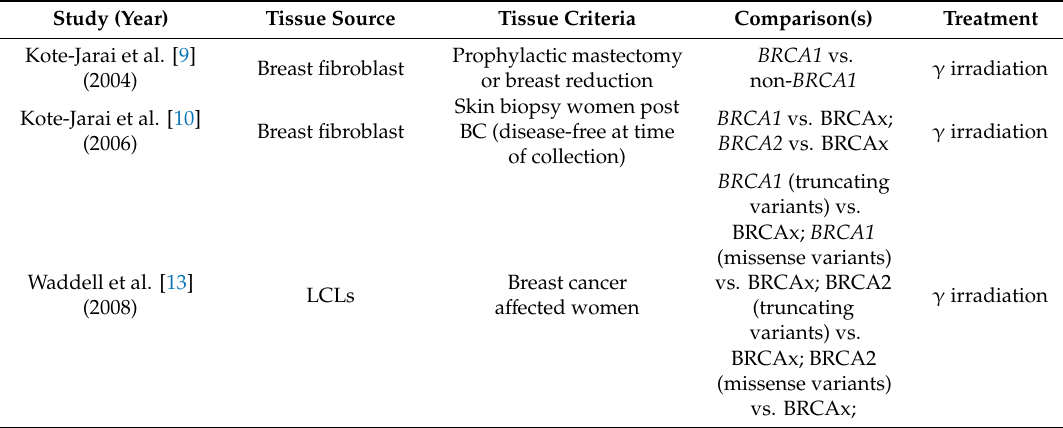
Table 3. A summary of design and methods within of studies focusing on normal tissue.